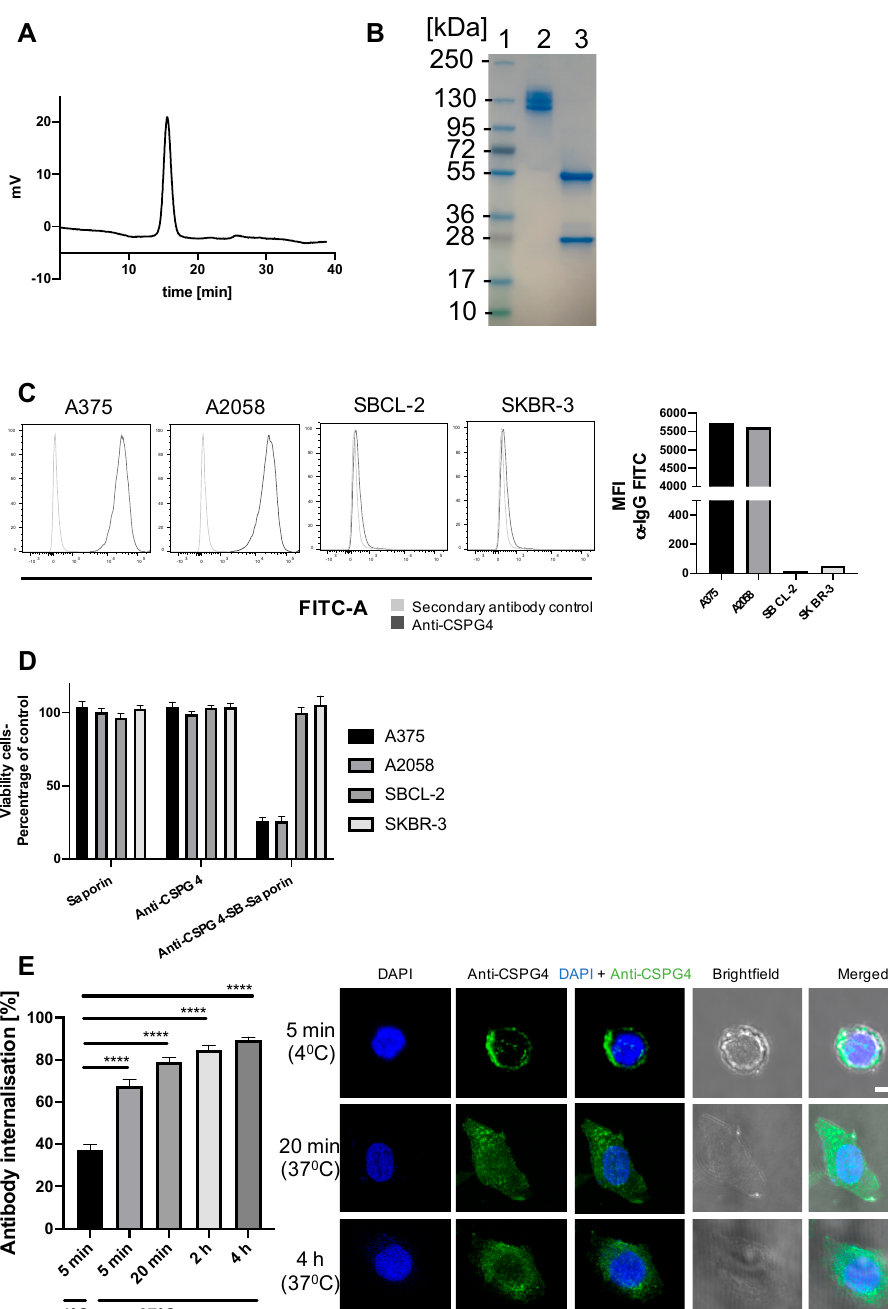
Figure 2. Anti-CSPG4-IgG1 antibody characterization and investigation of target-specific internalization. ( A ) HPLC trace of purified anti-CSPG4-IgG1 antibody; ( B ) SDS-PAGE followed by InstantBlue ® protein staining 1 (Expedeon, UK): Molecular weight standard 2: anti-CSPG4 antibody, 3: anti-CSPG4 antibody reduced; ( C ) Flow cytometric analyses (histograms and mean fluorescence intensity (MFI) values) of binding of anti-CSPG4 antibody to CSPG4-high and CSPG4-low cancer cell lines; ( D ) Investigation of cell viability of melanoma cell lines with high (A375, A2058) and low (SBCL-2, SKBR-3) CSPG4-expression. Tumor cells were treated with anti-CSPG4-Saporin, the naked antibody anti-CSPG4 and Saporin alone; ( E ) Investigation of anti-CSPG4 antibody internalization in the melanoma cell line A375 at di ff erent time points by confocal microscopy, error bars represent SEM, significance determined by one-way ANOVA with Dunnett’s multiple comparisons test; **** p < 0.0001; Scale bar 10 µ m, 40 ×